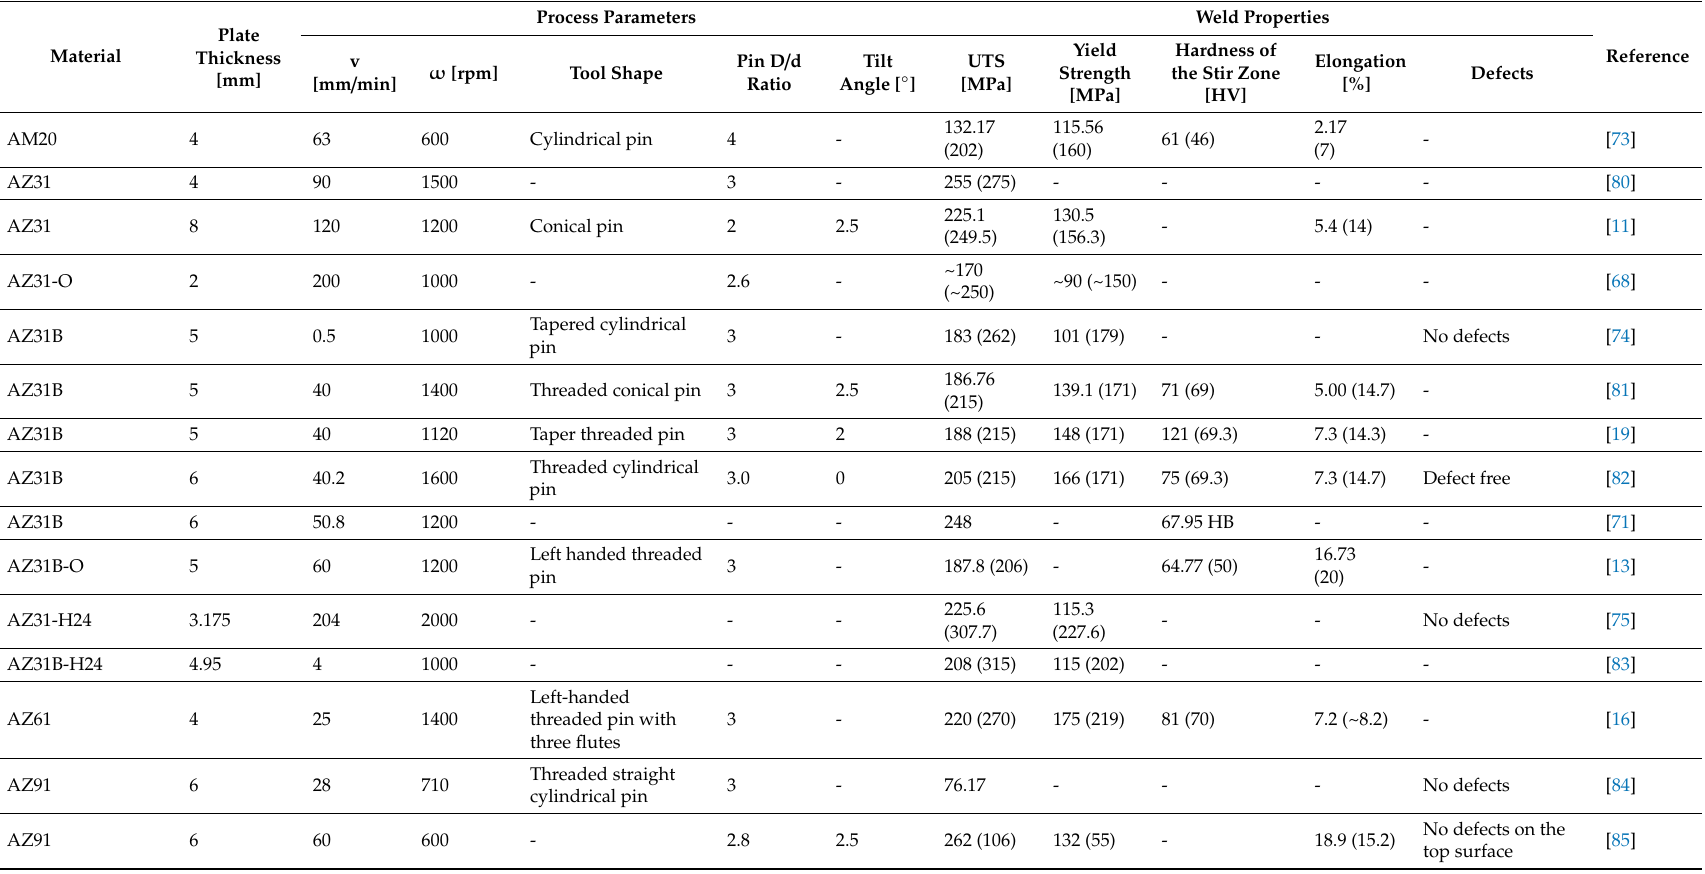
Table 2. FSW of magnesium and its alloys–process parameters and mechanical properties of the